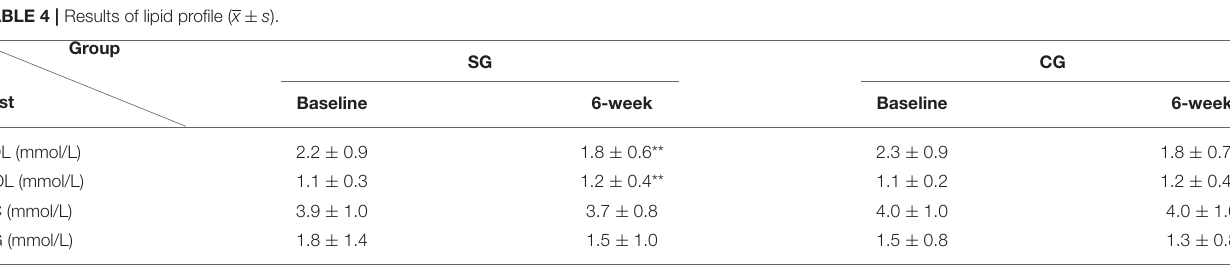
TABLE 4 | Results of lipid profile ( x ± s